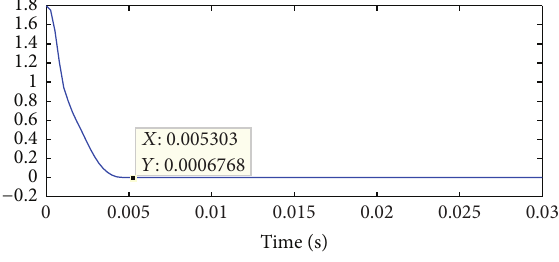
Figure 15: Recovered error of the message 𝑠(𝑡) .